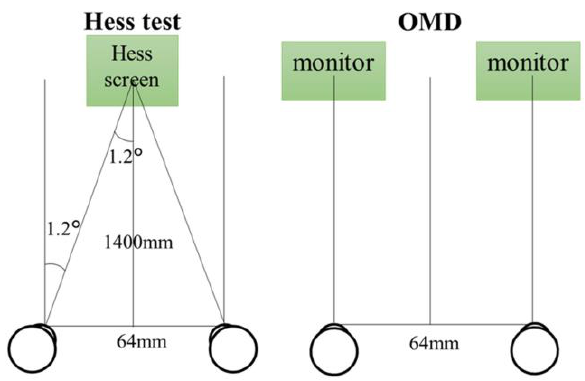
Figure 6: Difference in eye position between Hess test and OMD without